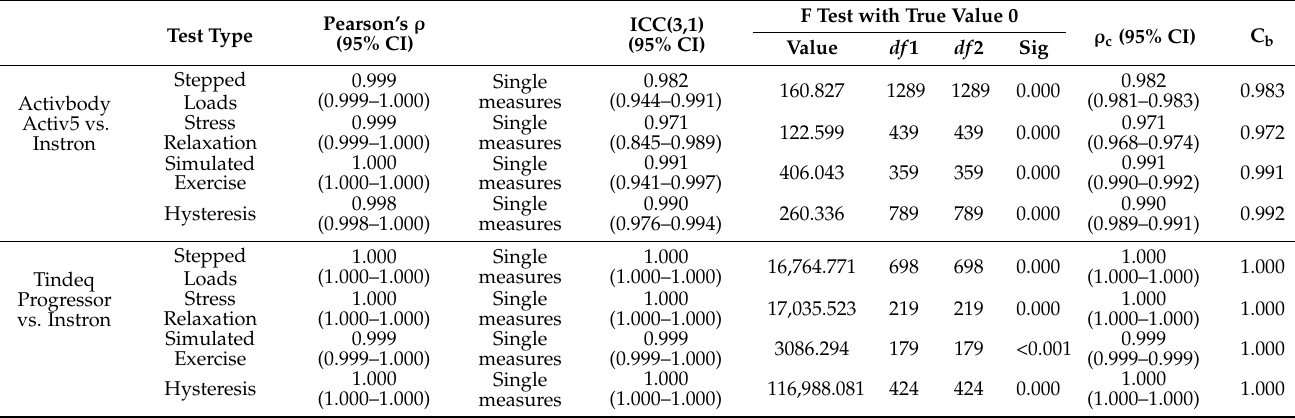
Table 3. Pearson’s correlations, interclass correlations, and concordance correlations comparing both the Activ5 and Progressor with the gold-standard measure (Instron) across all